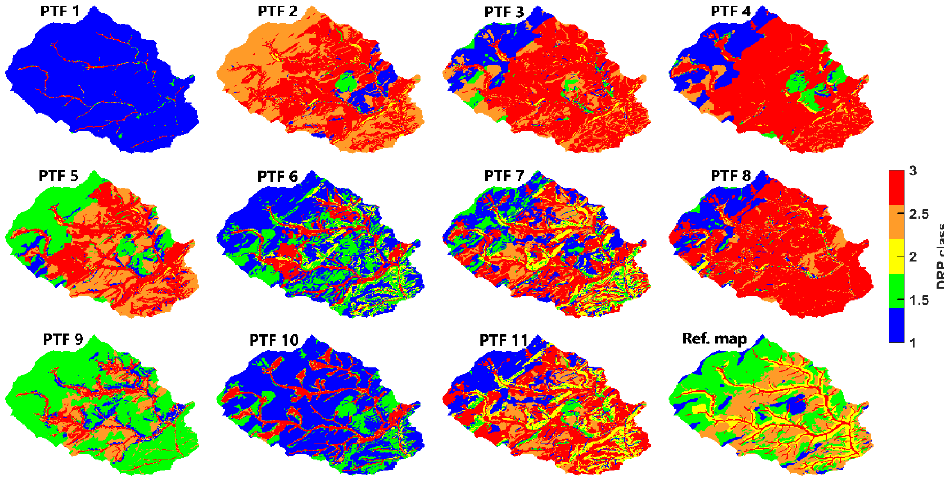
Figure 6. Spatial patterns of the simulated DRP classes for 11 PTFs and synthetic rainfall event of 100 mm/7 h, and the corresponding reclassified reference